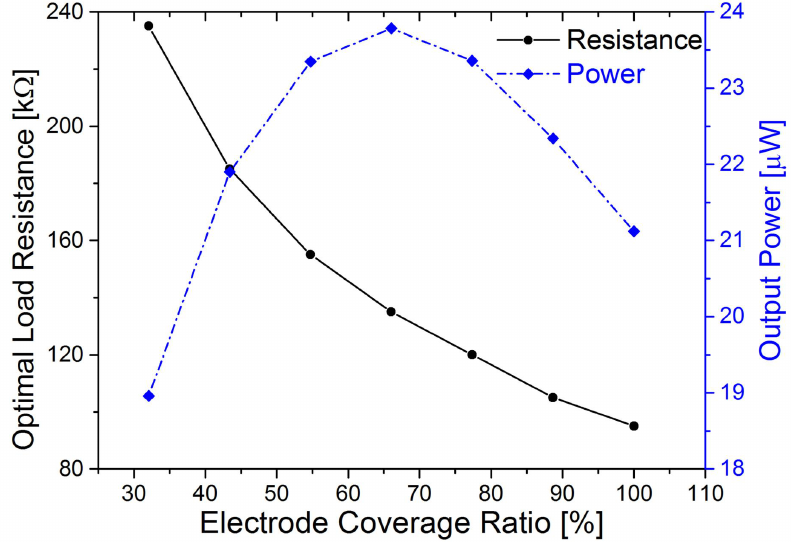
Figure 5. The variation of the optimal load resistance and the corresponding RMS output power against electrode coverage